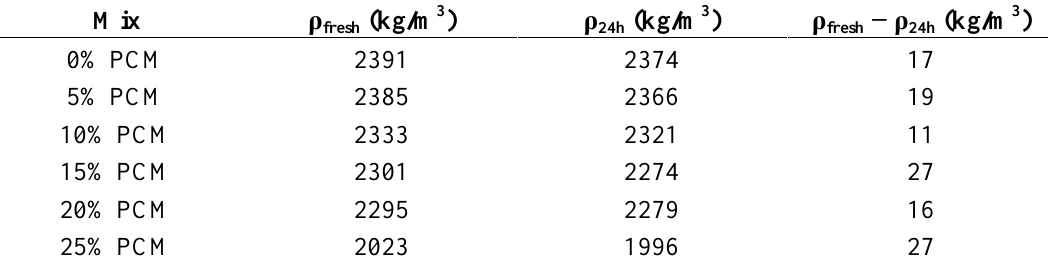
Table 5. Average densities.